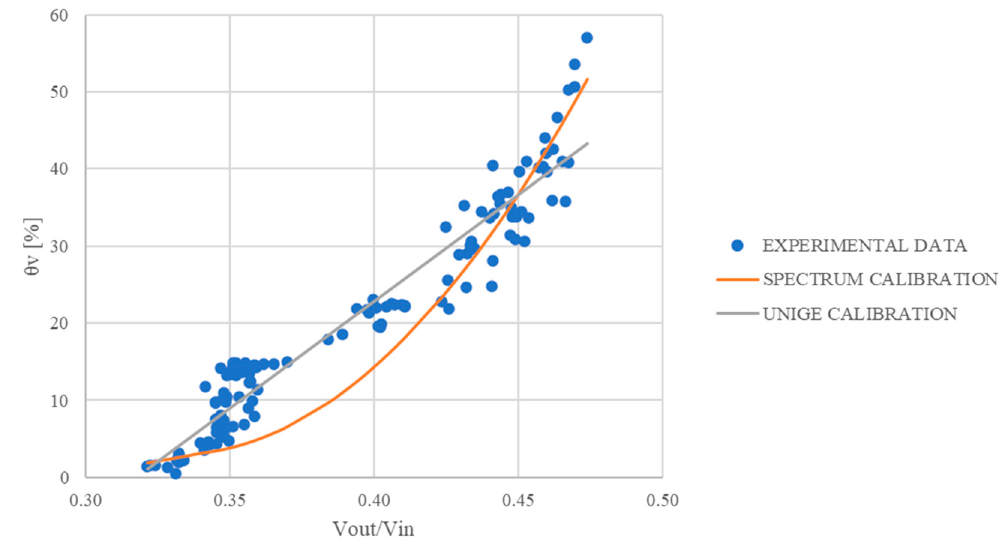
Figure 17. Comparison between the Spectrum Tec. calibration law (SPECTRUM CALIBRATION) and the soil-specific calibration law determined by the University of Genoa (UNIGE CALIBRATION). Table 5. Calibration function. R 2 : coefficient of determination; RMSE: root mean square error.